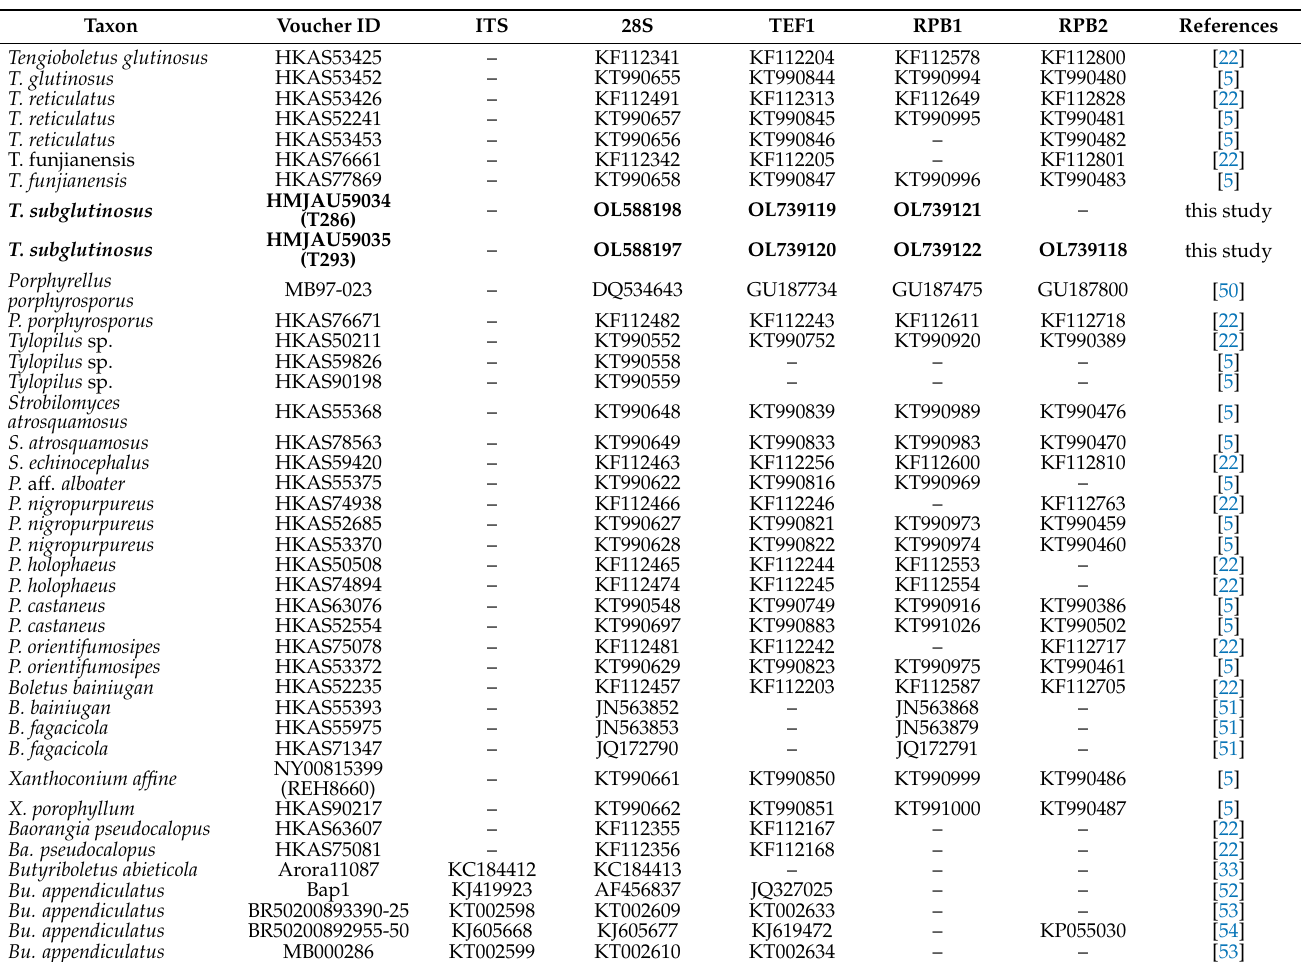
Table 1. Information of DNA sequences used to reconstruct phylogenetic trees. Sequences newly generated in this study are indicated in